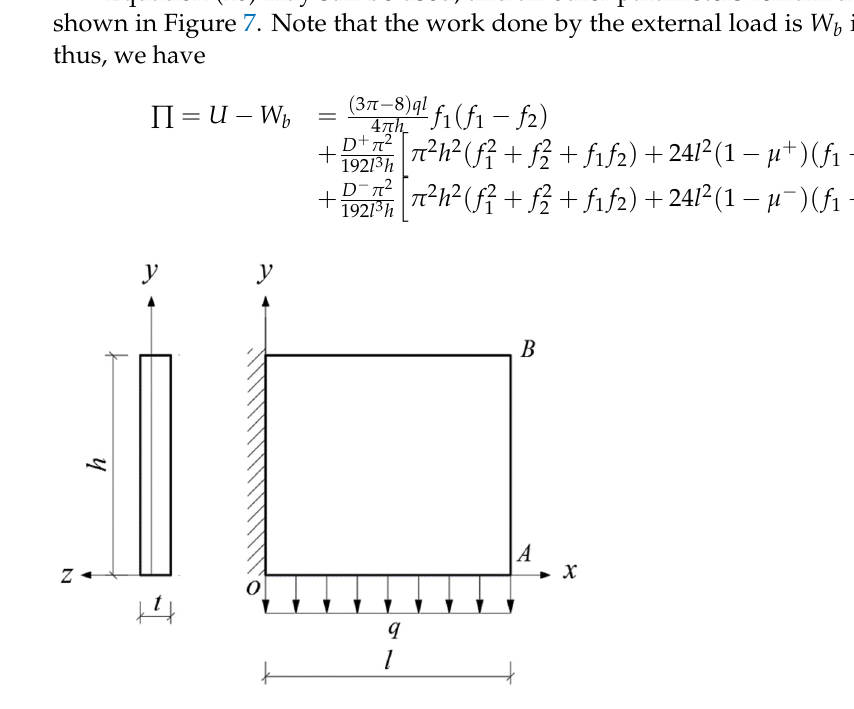
Figure 7. Bimodular rectangular plate with bottom